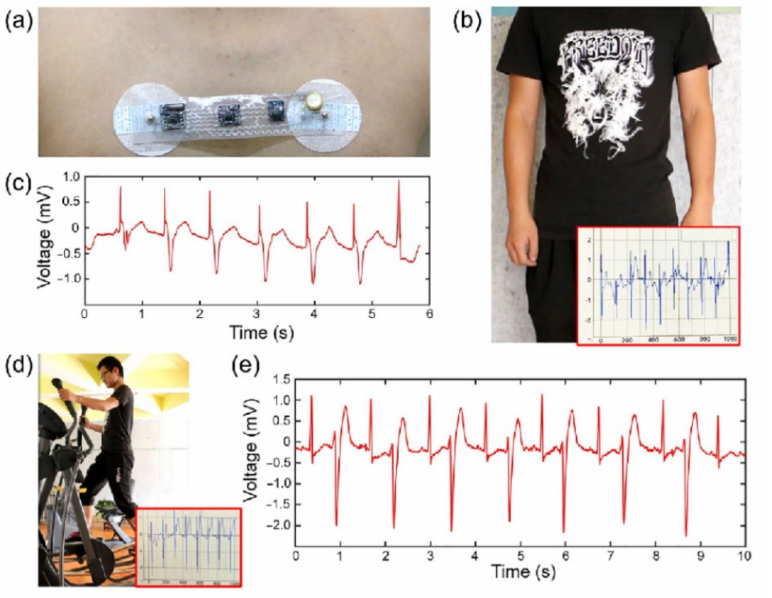
Figure 19. ( a ) LM e-Skin ECG device. ( b ) When the human body is stationary, the LM e-Skin collected the signal and displayed it on the computer. ( c ) ECG data processed by MATLAB. ( d ) When the human body moved, the LM e-Skin collected signal and displayed it on the computer. ( e ) ECG data in motion processed by MATLAB. Reprinted with permission from Ref. [64]. Copyright 2018 Springer